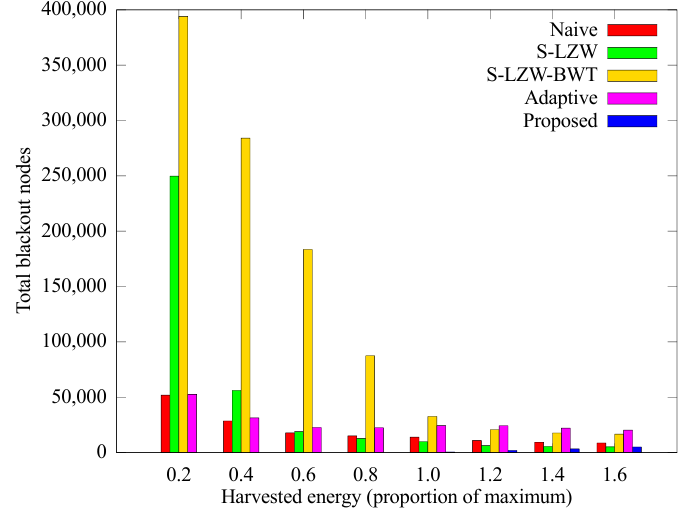
Figure 14. Comparison of the number of blackout nodes according to the solar energy.